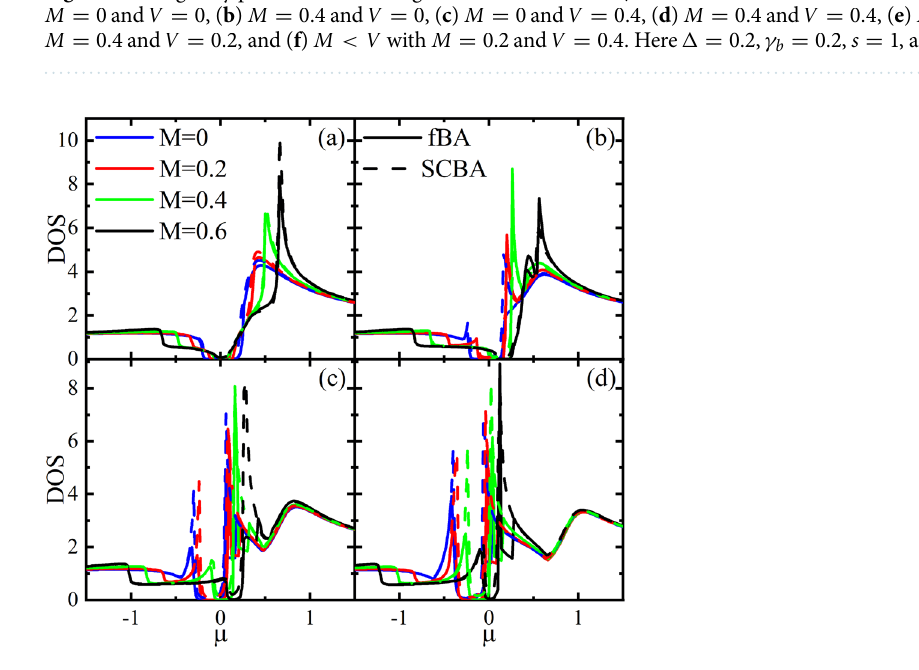
Figure 5. Dependence of DOS on the µ in the fBA and SCBA methods with γ b = 0.2 for different values of M and ( a ) V = 0 , ( b ) V = 0.2 , ( c ) V = 0.4 , and ( d ) V = 0.6